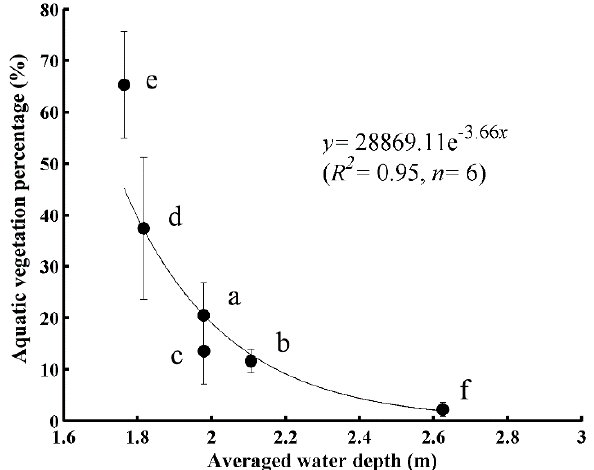
Figure 9. Relationship between average water depth and the percentage covered by aquatic vegetation in the six regions: ( a ) Zhushan Bay, ( b ) Meiliang Bay, ( c ) Gonghu Bay, ( d ) Xukou Bay, ( e ) East Lake Taihu and ( f ) Open